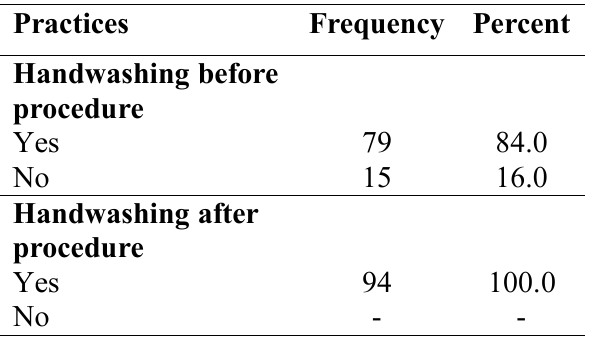
Table 4: Daily care practices N =